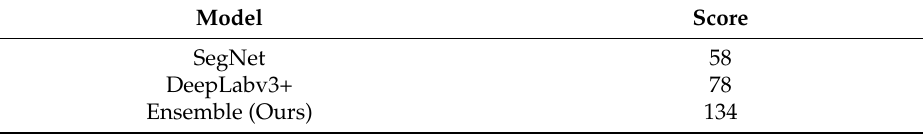
Table 3. User study result.